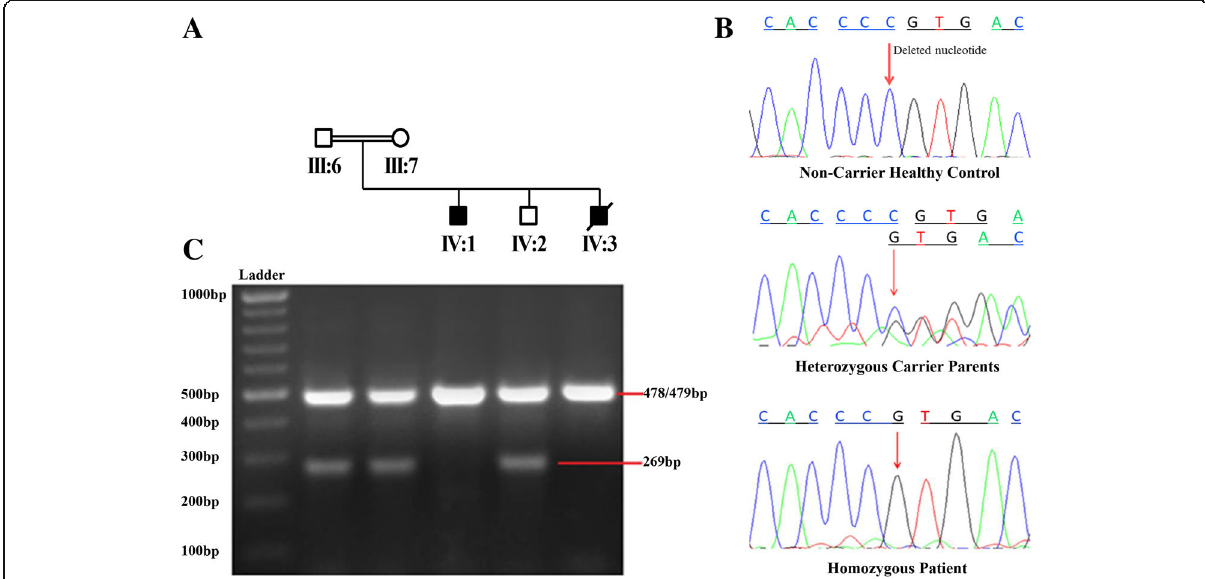
Fig. 3 Mutation analysis. a Branch of the affected family subjected to mutation analysis. b Sanger sequencing of exon 6 of the TCIRG1 gene illustrating c.624delC (p.P208PfsX1) variation. The affected individuals are homozygous for this deletion, whereas phenotypically normal parents are found heterozygous having normal as well as mutant allele. Site of variation is indicated by arrow. c Allele-specific amplification is also supporting the homozygous deletion mutation as allele-specific band of 269 bp is present in carrier individuals (III-6, III-7, IV-2) while absent in affected subjects (IV-1 &